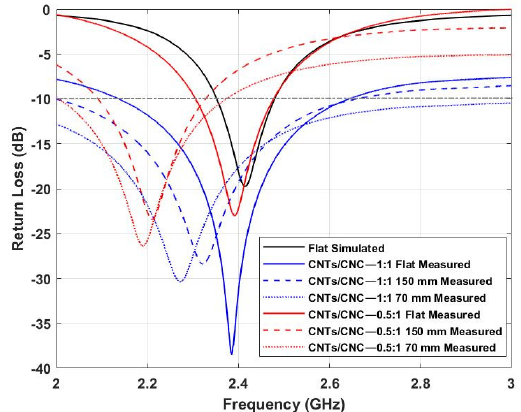
Figure 15. Simulated vs. Measured S 11 of CNTs/CNC LOOP antennas under 70 and 150 mm bending scenarios.